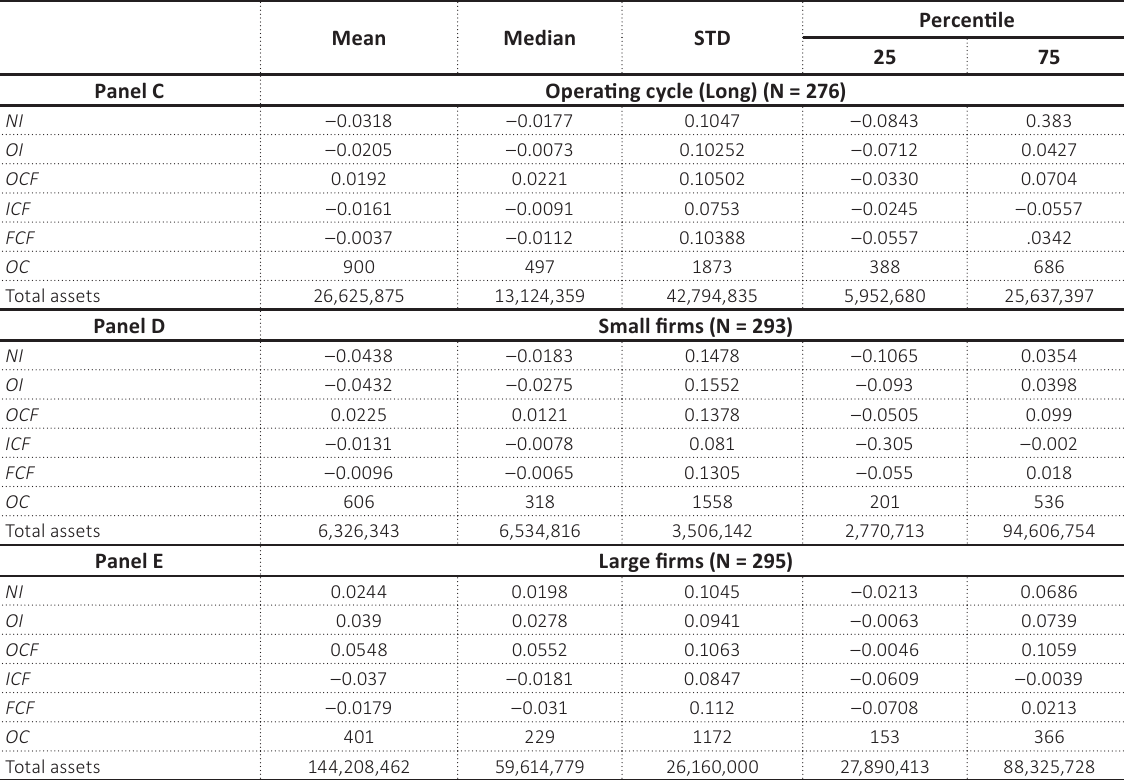
Table 1 (cont.). Descriptive statistics